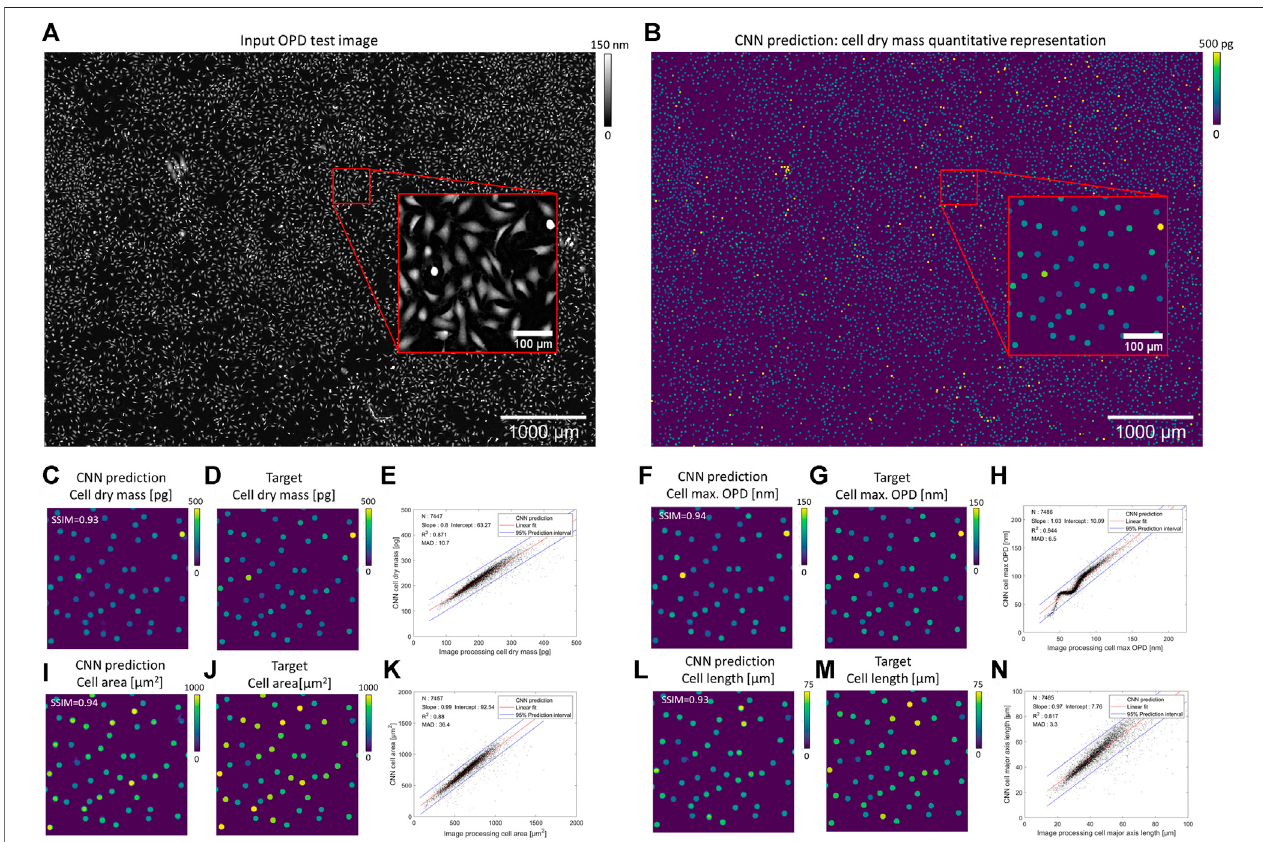
FIGURE3| ResultsofCNN-basedquanti fi cationscomparedwithgroundobtainedwithstandardimageprocessing (A) OPDtestimagefeaturing7,568 fi broblasts. (B) CNNpredictionofacelldrymassquantitativerepresentation.Forbettervisualization,discshavebeendilatedin (B) . (C,F,I,L) Quantitativerepresentationspredicted by the CNN on the OPD cropped image (red box in (A) ) for cell dry mass, cell maximum OPD value, cell area, and cell major axis length. Corresponding ground truth representationsaredepictedin (D,G,J,M), respectively. (E,H,K,N,S) Pair-wisecomparisonsbetweenpredictedandgroundtruthvaluesforthefour cellmetrics over N (cid:1) 7,450 cells. The results of the linear regressions and the error MAD calculation ( Eq. 6 ) are indicated in the fi gures.